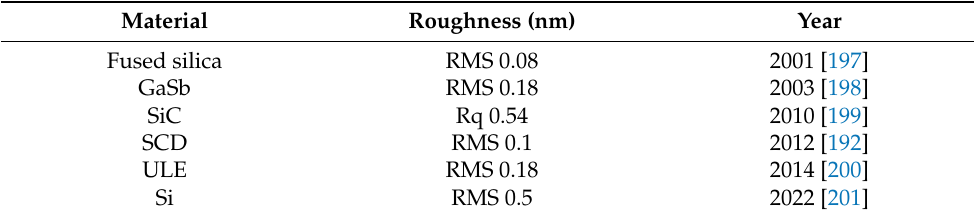
Table 8. The ultimate roughness achieved with IBF for different materials.